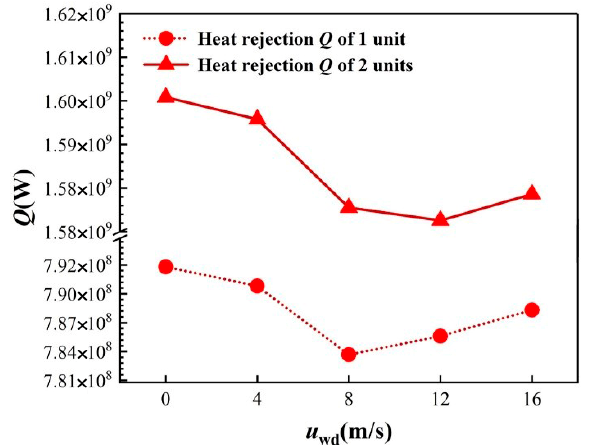
Figure 18. Heat rejections of NDDCS with one tower in the cases of 2 units and 1 unit under typical crosswind speeds.